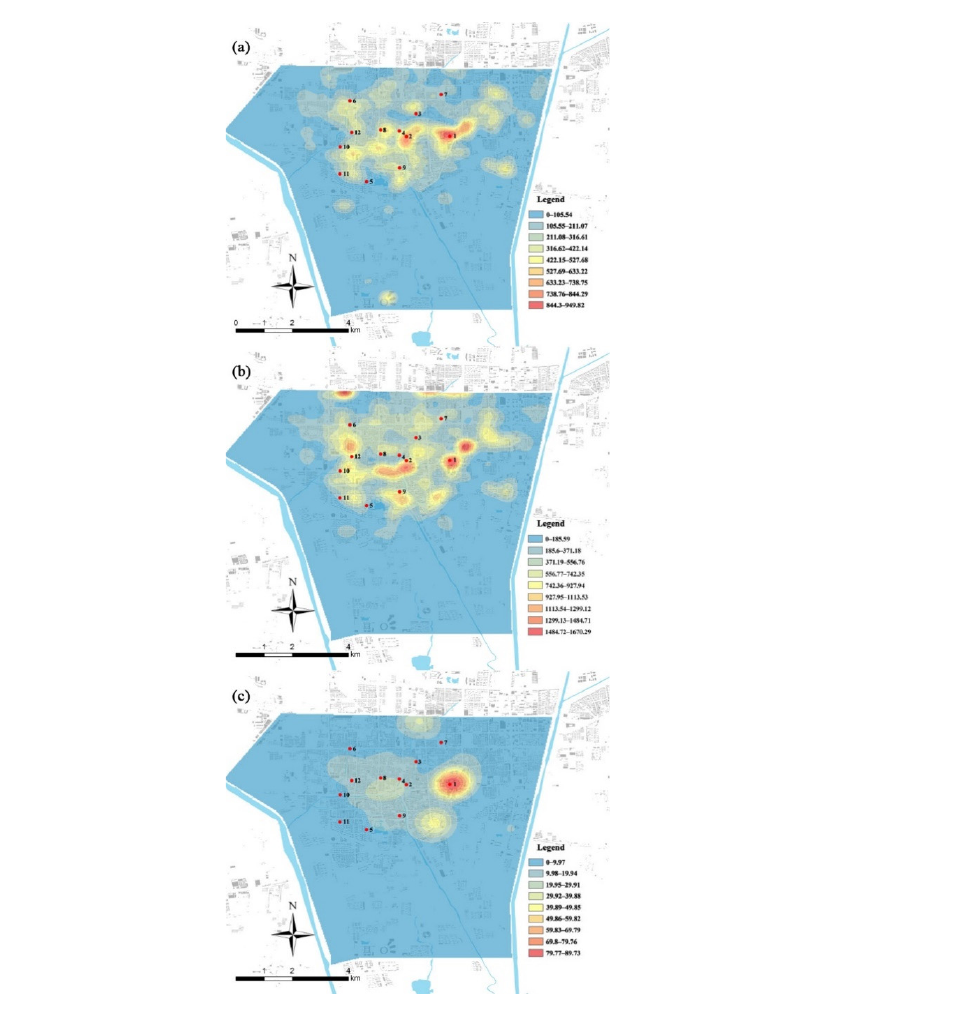
Figure 5. POI analysis of catering, entertainment, and tourism facilities: ( a ) POI analysis of catering facilities; ( b ) POI analysis of entertainment facilities; ( c ) POI analysis of tourism facilities. Table 5. Correlation between facilities kernel density and facilities satisfaction.